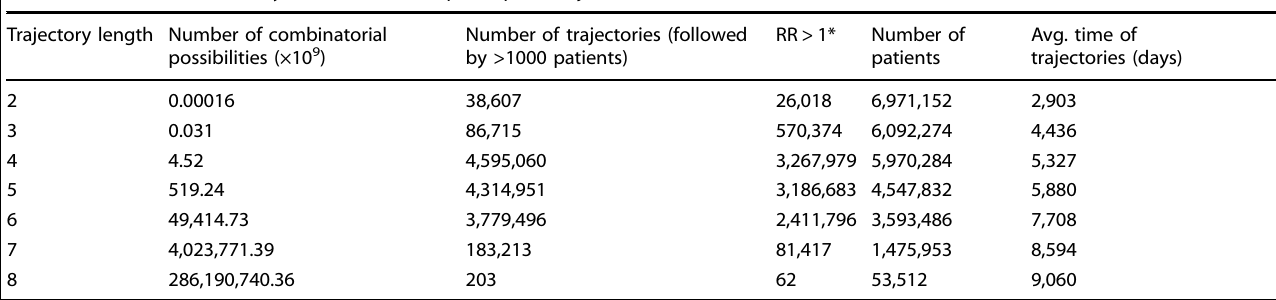
Table 1. Quantitative summary of the number of prescription